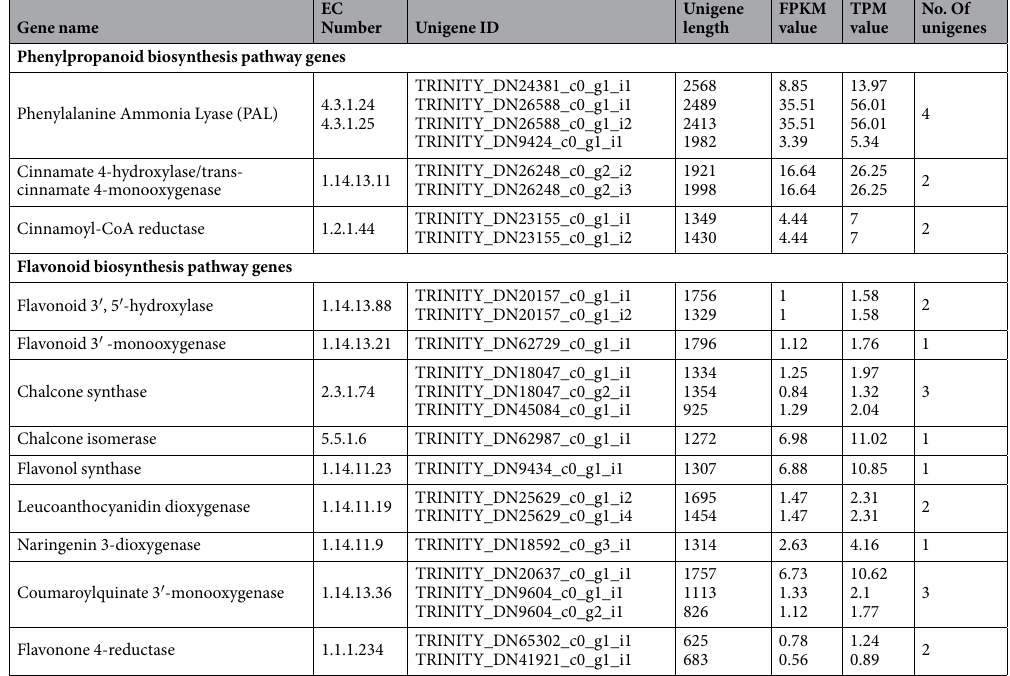
Table 3. Major genes involved in phenylpropanoid and flavonoid biosynthesis pathways identified from Solanum trilobatum leaf